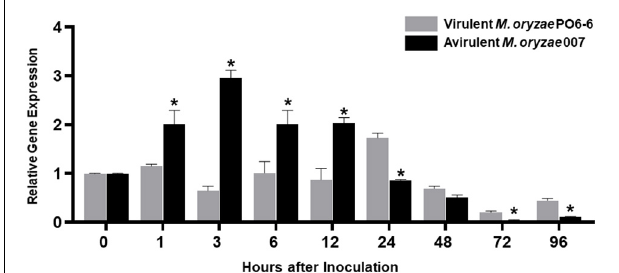
M. oryzae 007 ( Figure 3C ). Rice DJ and 35S: OsMEK2 #4 leaves displayed a typical resistant reaction with small necrotic,